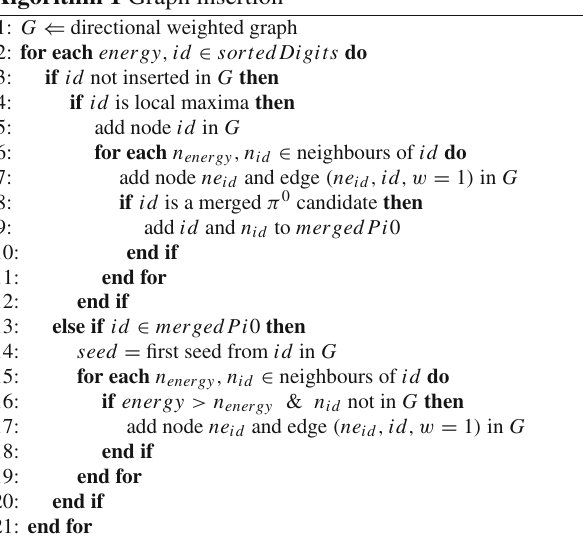
Algorithm 1 Graph